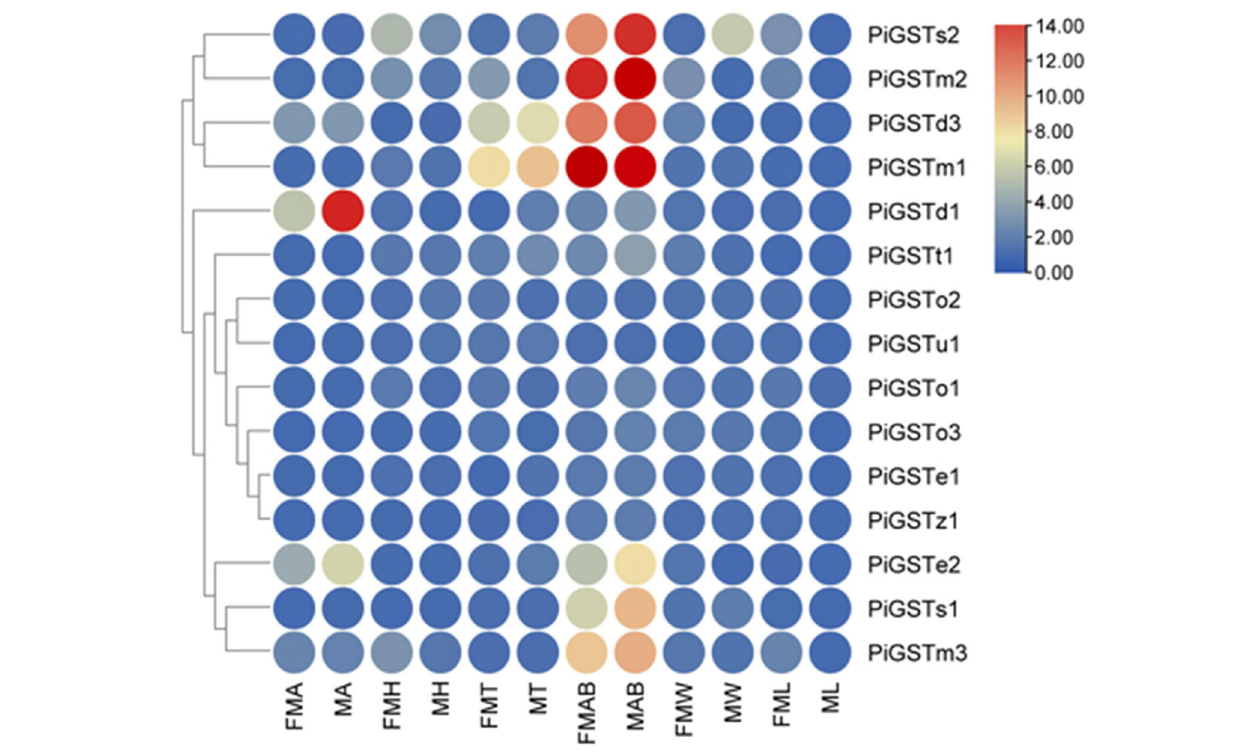
FIGURE 3 | Tissue expression pattern of the PiGST Genes. Levels of gene expression were normalized relative to that in the leg (one-fold). FMA, female antennae; MA, male antennae; FMH, female heads; MH, male heads; FMT, female thoraxes; MT, male thoraxes; FMAB, female abdomens; MAB, male abdomens; FMW, female wings; MW, male wings; FML, female legs; ML, male